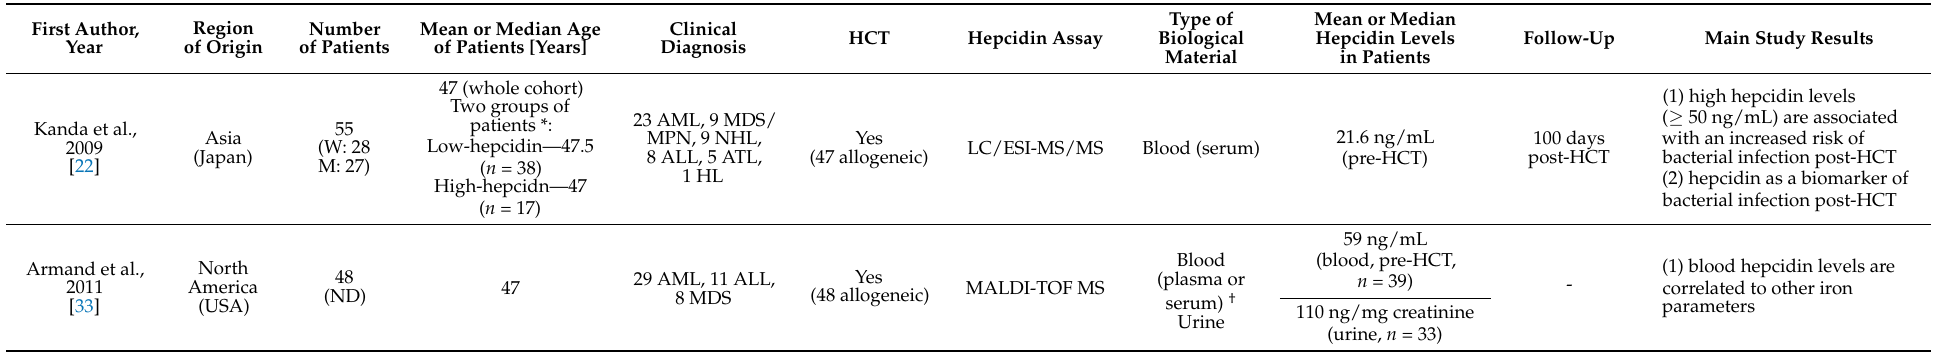
Table 2. Characteristics of the four cohort studies and the two cross-sectional studies included in a systematic